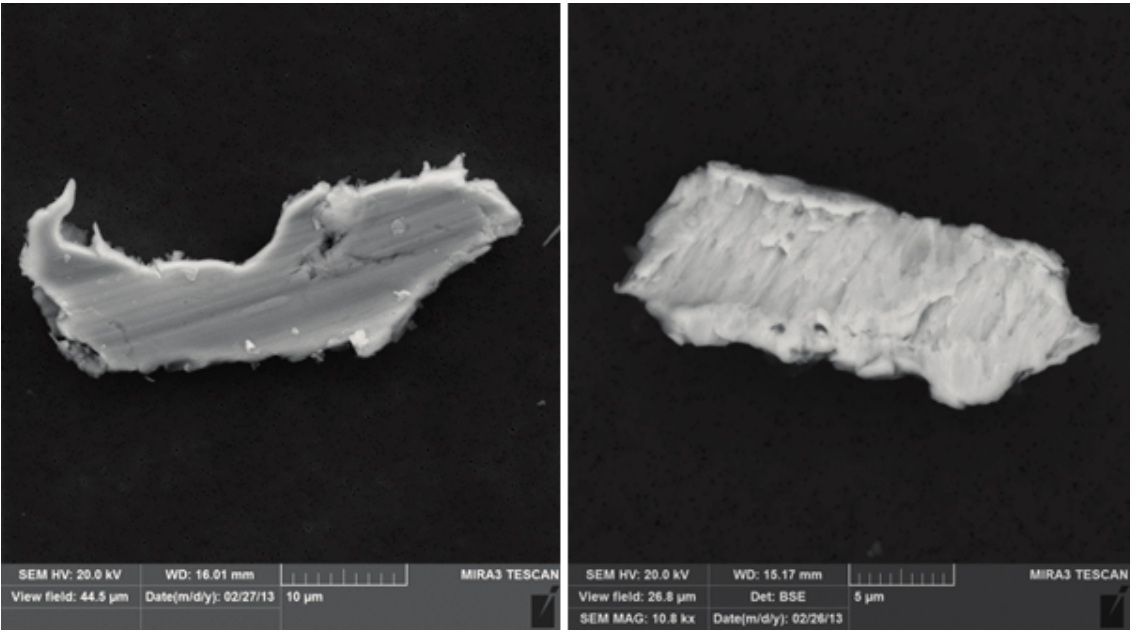
Figure 2. Stainless steel particles collected in Jegi subway station showing surface features characteristic of wear processes. Such particles were typically larger than 10 µm and were unique to the Jegi site. The EDX spectra showed Fe, Cr, and